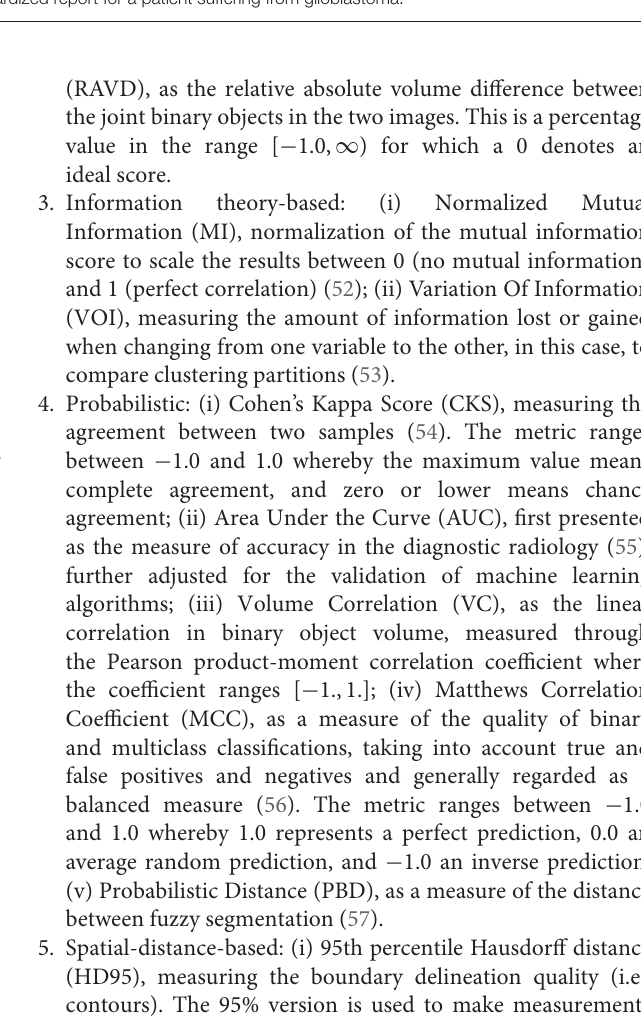
FIGURE 3 | Illustration of the Raidionics-Slicer plugin after generating the standardized report for a patient suffering from